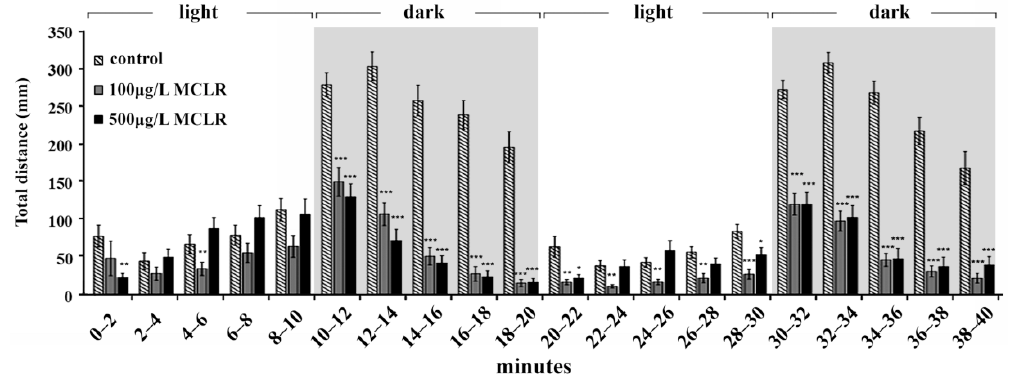
Figure 3. Behavioral patterns of MCLR-treated zebrafish larvae. The locomotor activity displayed by controls (0.05% ethanol) and treated larvae with 100 μ g/L and 500 μ g/L of MCLR is represented by the total distance covered in 2 min time bins. Tracking was performed under variable lighting conditions. Light phases correspond to 0–10 min and 20–30 min and dark phases to 10–20 min and 30–40 min time periods. * p < 0.05, ** p < 0.01, and *** p < 0.001 comparing each treatment to the control group.